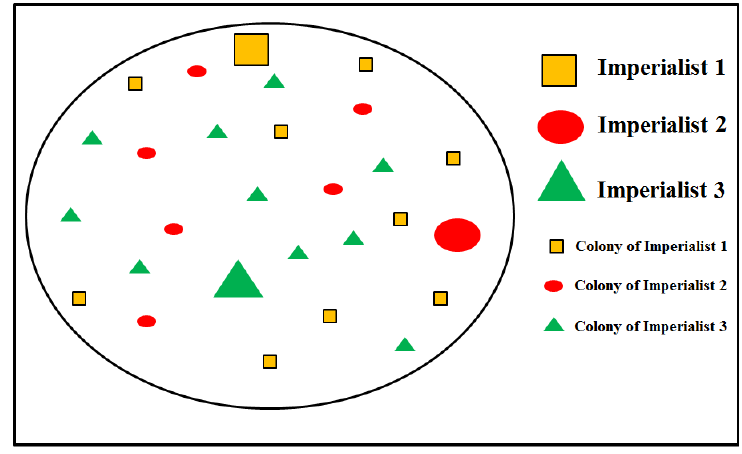
Figure 5. A framework population of the ICA algorithm.